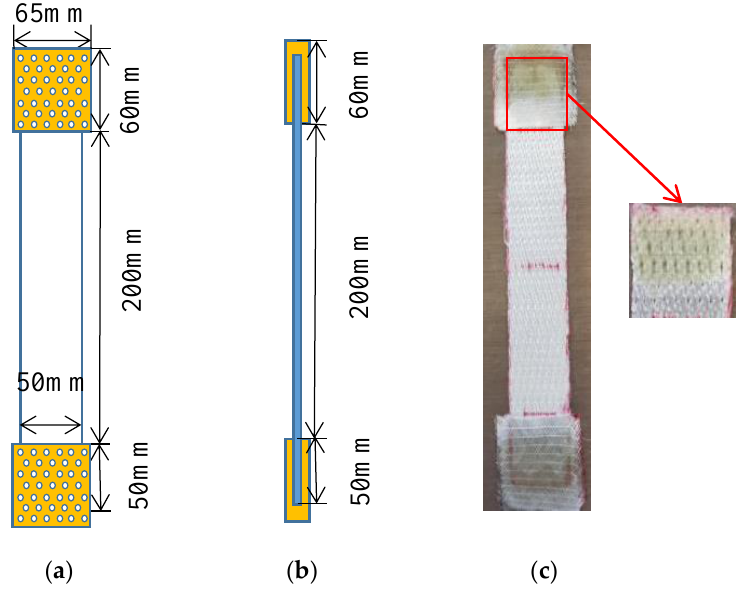
Figure 2. Methods of avoiding testing slippage by adhesive bonding on both ends with an extension of 50 mm: ( a ) the front photographic and schematic view; ( b ) schematic view of side plan; ( c ) actual operation.